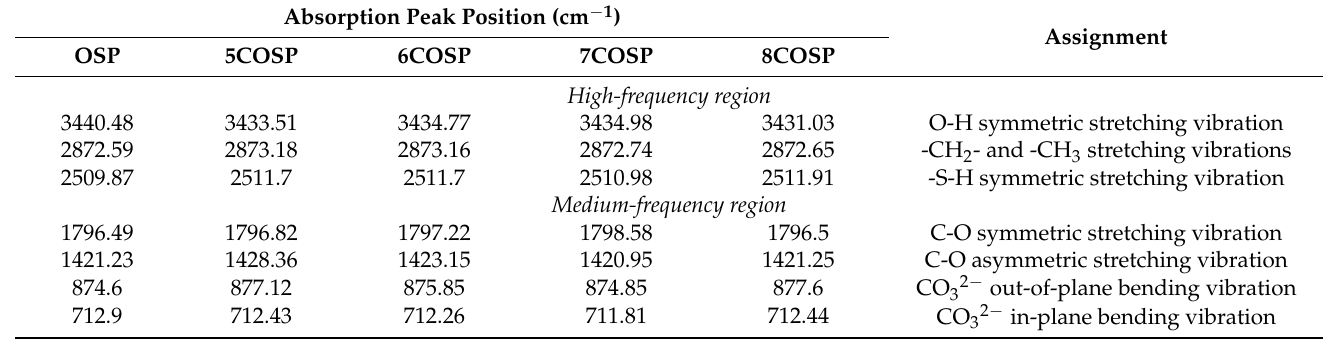
Table 2. Infrared spectrum assignment of pre- and post-calcined OSP.